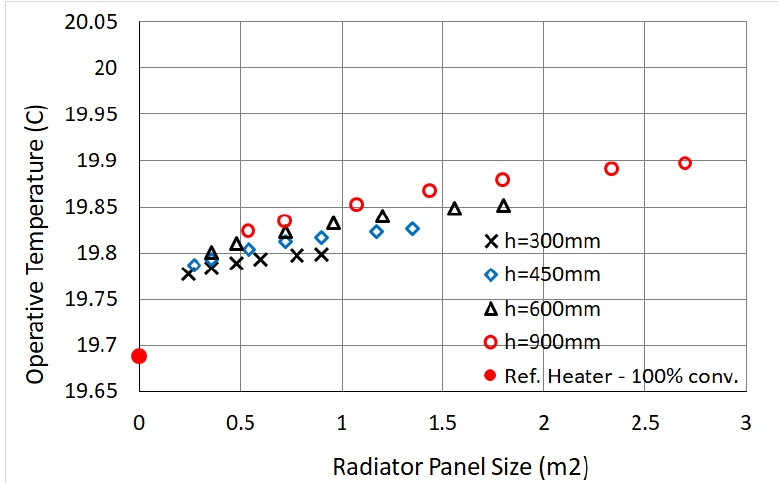
Figure 8. IDA ICE operative temperatures for a 21-type radiator and convector in function of the panel area.